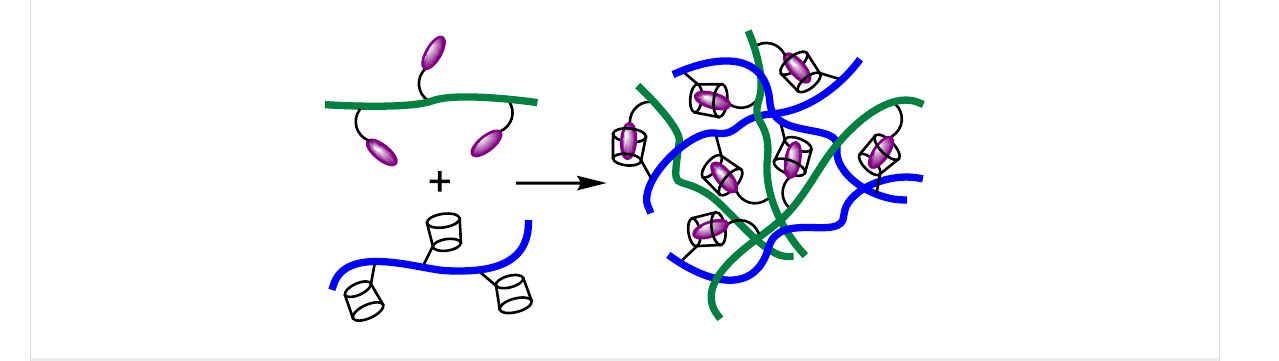
Figure 6: Host–guest complexation between polymers with cyclodextrin and hydrophobic substituents.